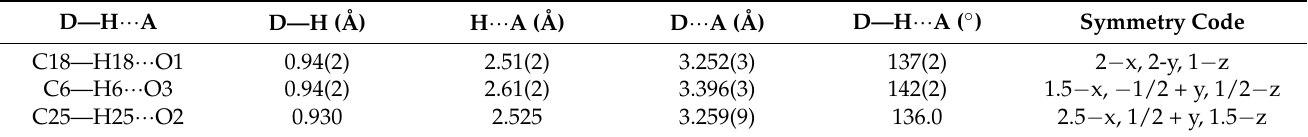
Figure 3. C6—H6 ··· O3 ( a ) and C25—H25 ··· O2 ( b ) interactions maintain a layered patter stacked by C18—H18 ··· O1 ( c ) interactions. Table 3. Geometric parameter of the C—H ··· O interactions in QBCP.